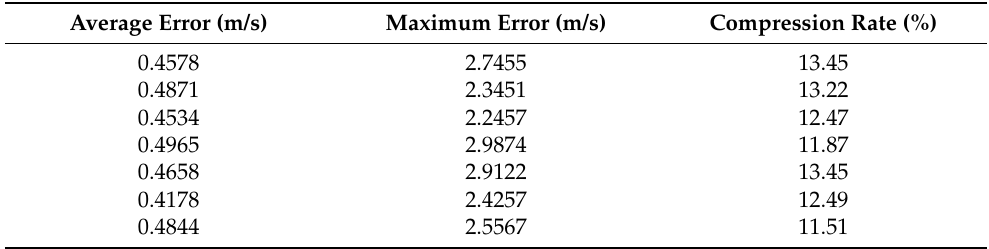
Table 1. Dictionary learning compression performance parameter under the spatio-temporal combi- nation structure.